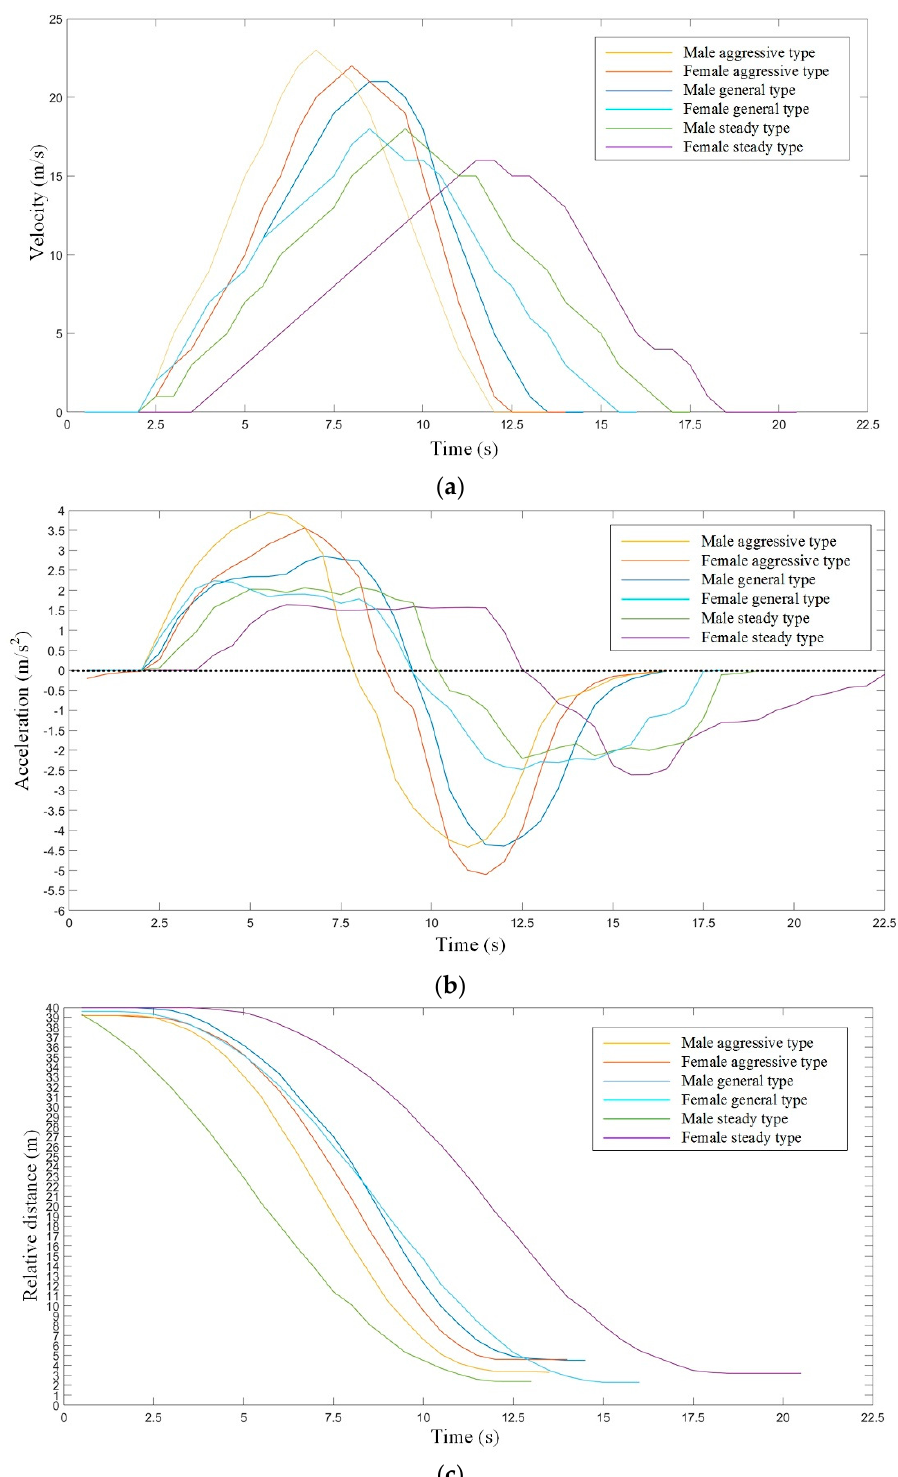
Figure 4. The experimental results for different driving types with different genders based on car-following: ( a ) the velocity for six driving types; ( b ) the acceleration for six driving types; and ( c ) the relative distance for six driving types.